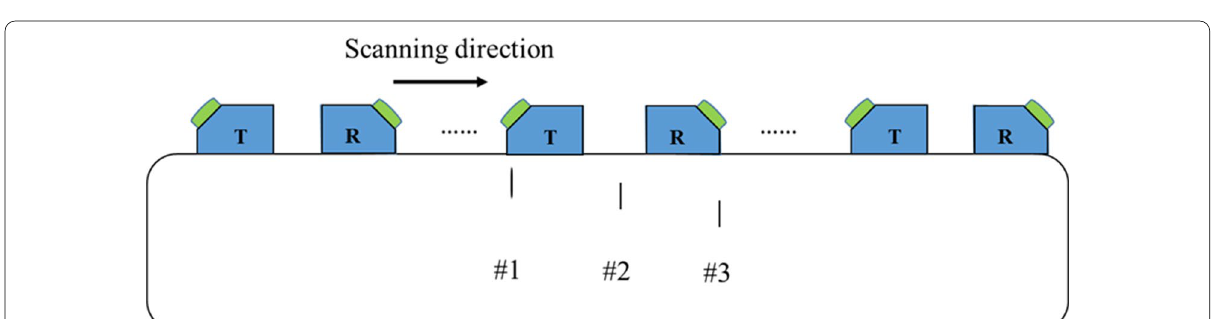
Figure 2 Flow chart of Sparse-SAFT